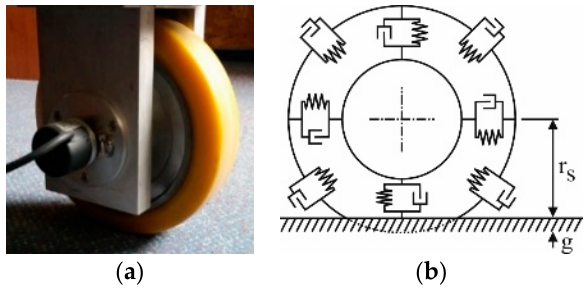
Figure 2. Vehicle wheel ( a ) view; ( b ) model, g —deflection, r S —static radius.